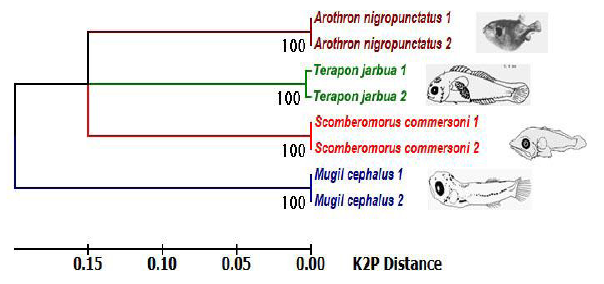
Fig. 2. Phylogenetic relationship of Mugil cephalus, Scomberomorus commersoni, Arothron nigropunctatus, Terapon jarbua from Vellar